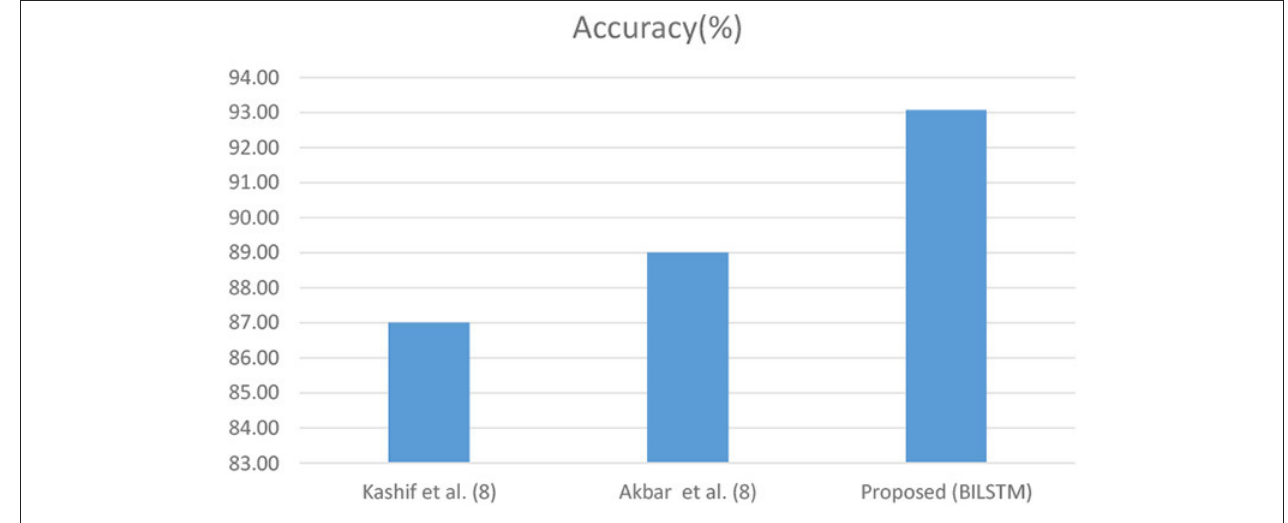
FIGURE 16 | Comparison of other research and the BiLSTM model.